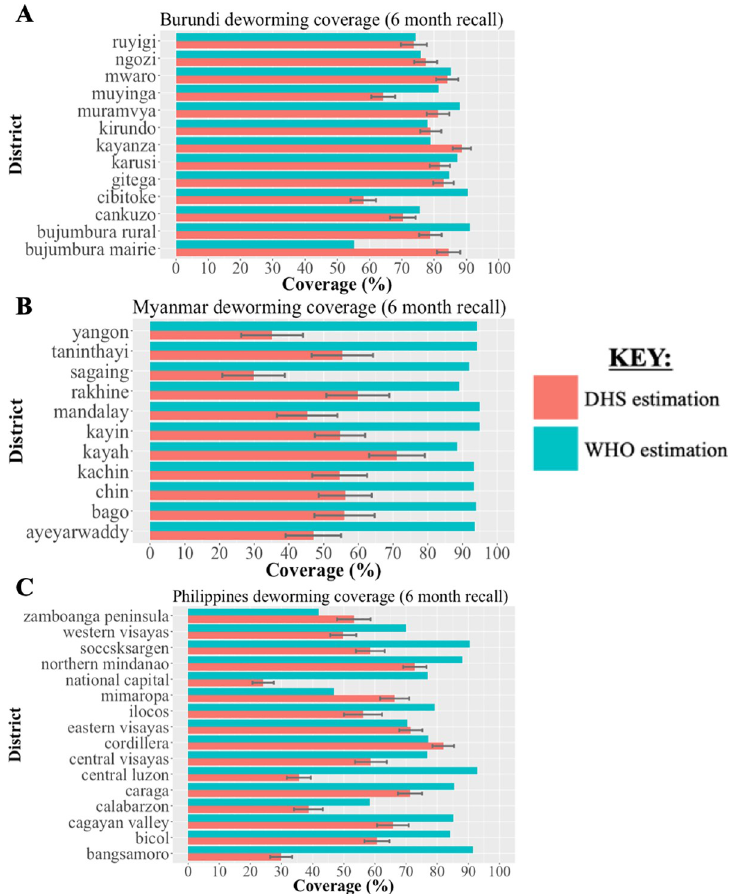
Fig 4. Comparison of district-level deworming coverage in pre-school aged children reported to WHO and estimated by DHS data for study countries. We obtained WHO data on district-level deworming coverage reported by national Ministries of Health based on health facilities data. We estimated district-level deworming coverage from DHS data corresponding to the known WHO deworming campaigns using maternally-reported data on child deworming receipt. The comparison of deworming coverage using WHO and DHS data are shown for a base case recall period of 6-month in Burundi (panel A), Myanmar (panel B) and the Philippines (panel C) based on the DHS question